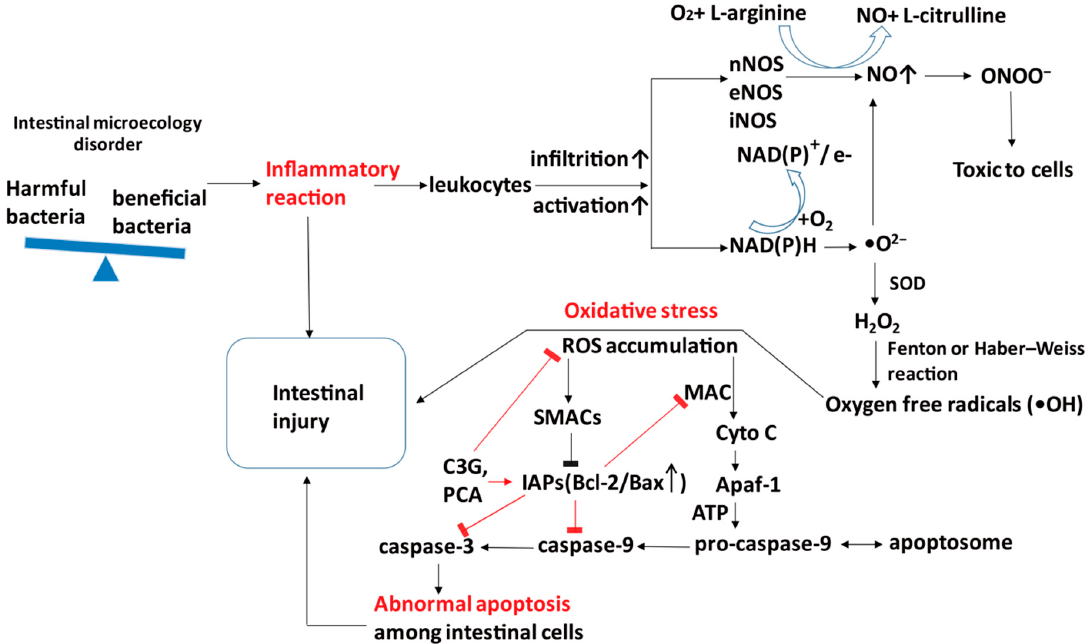
Figure 5. Potential mechanisms of C3G&C3G-Ms against apoptosis in intestinal epithelial cells. Intestinal flora disorder can induce the overproduction of pro-apoptotic factors such as ROS to increase mitochondrial permeability and cause the release of SMACs to bind and inactivate IAPs, such as Bcl-2. Since IAPs inhibit the activation of MAC and caspase to inhibit apoptosis, the inactivation of IAPs will induce the release of Cyto C through MAC, and subsequently induce the expression of Apaf-1 and caspase to cause apoptosis. C3G and its metabolites PCA can directly quench ROS and activate IAPs to inhibit the release of Cyto C and expression of caspases. Apaf-1, apoptotic protease activating factor-1; Cyto C, cytochrome C; C3G, cyanidin 3-glucoside; IAPs, inhibitor of apoptosis proteins; MAC, mitochondrial apoptosis-induced channel; PCA, protocatechuic acid; ROS, reactive oxygen species; SMACs, second mitochondria-derived activator of caspases.